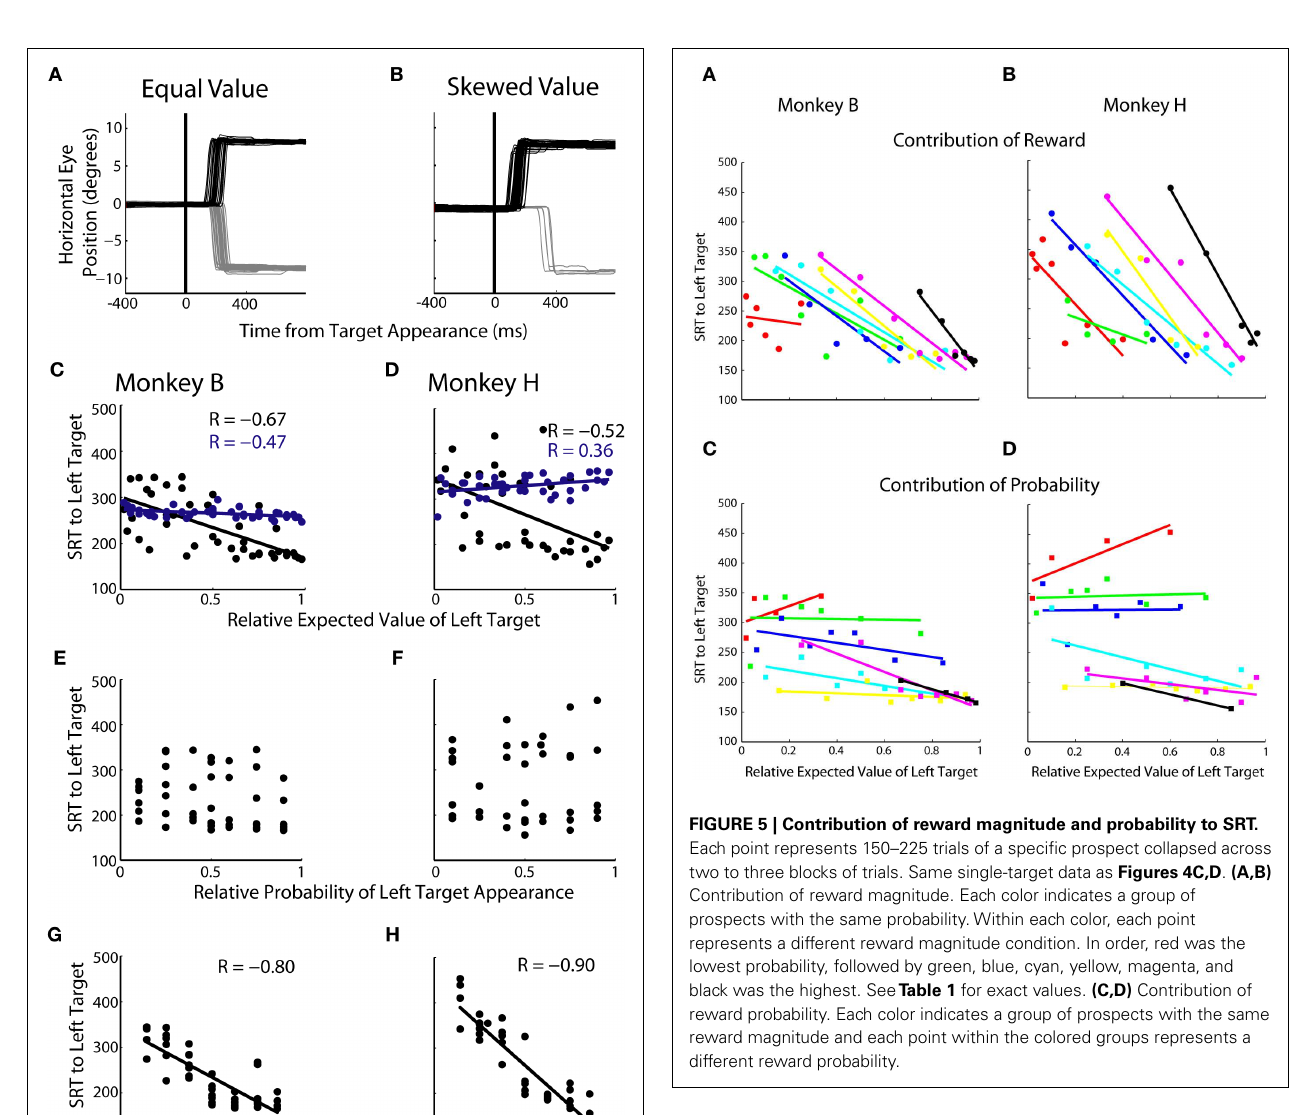
and SRT ( Figure 4C ; Monkey B; R = − 0.47, Figure 4D ; Monkey H; R = 0.36).